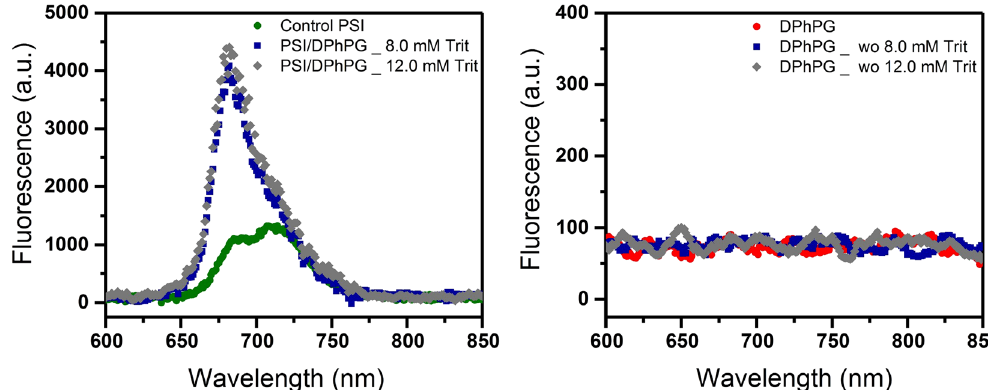
Figure 8. Room temperature fluorescence emission spectra of: (left panel) control PSI and PSI-proteoliposomes reconstituted at different point of second stage of solubilization; (right panel) control DPhPG liposomes and DPhPG liposomes suspension after detergent